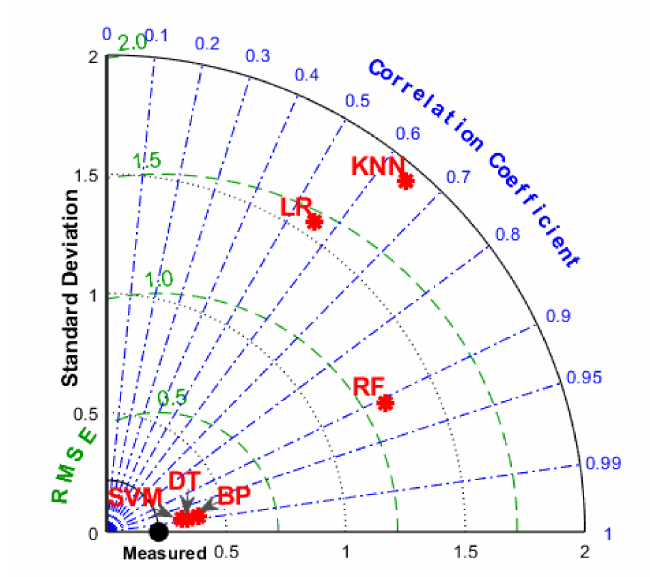
Figure 9. Taylor diagram for presenting the predictive e ff ect of six